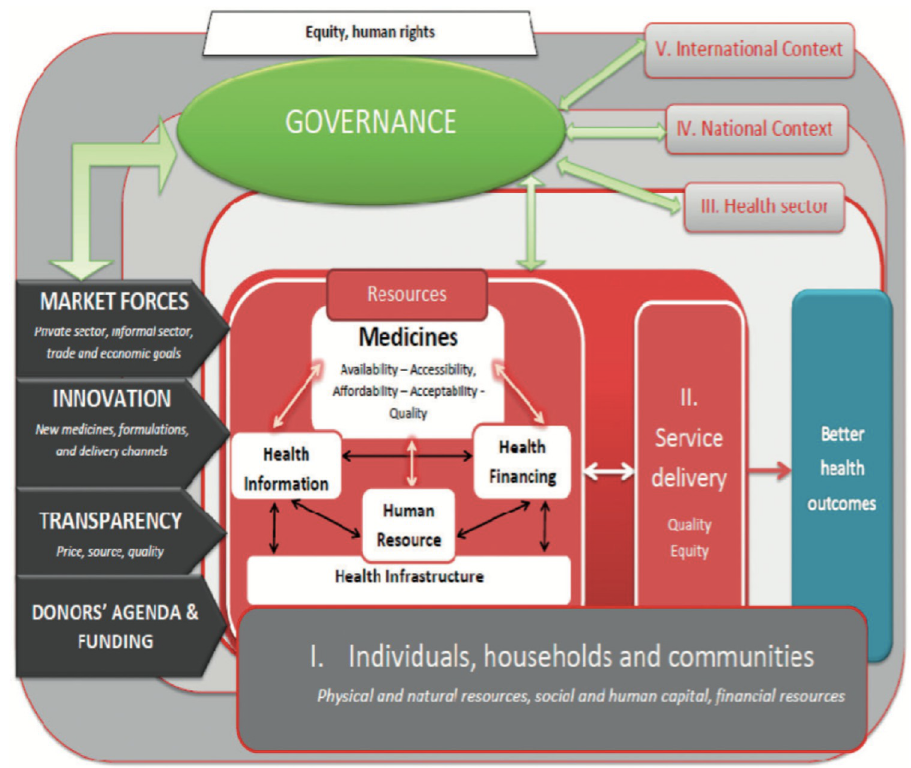
provided the original work is properly